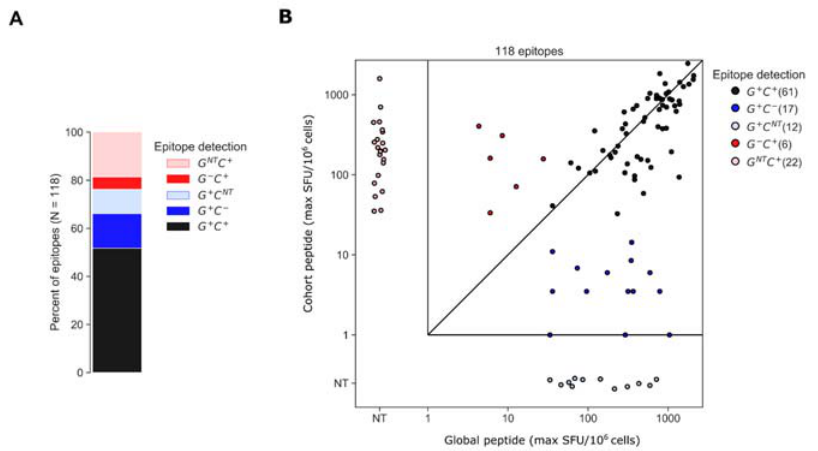
Figure 5. Epitopes identified by global and cohort peptide responses. ( A ) Epitopes were categorized based on whether they were detected by both global and cohort peptides (G + C + ), global-only (G + C − or G + C NT ) or cohort-only peptides (G − C + or G NT C + ). If no peptides overlapping the epitope were tested from a given set, due to negative pool-level responses the epitope is indicated as not-tested (NT) for that set ( B ) Plot indicates the maximum magnitude of the peptide responses among all peptides overlapping the epitope from each peptide set. Maximum response magnitudes among G + C + epitopes were positively correlated (R = 0.71, p < 0.001).